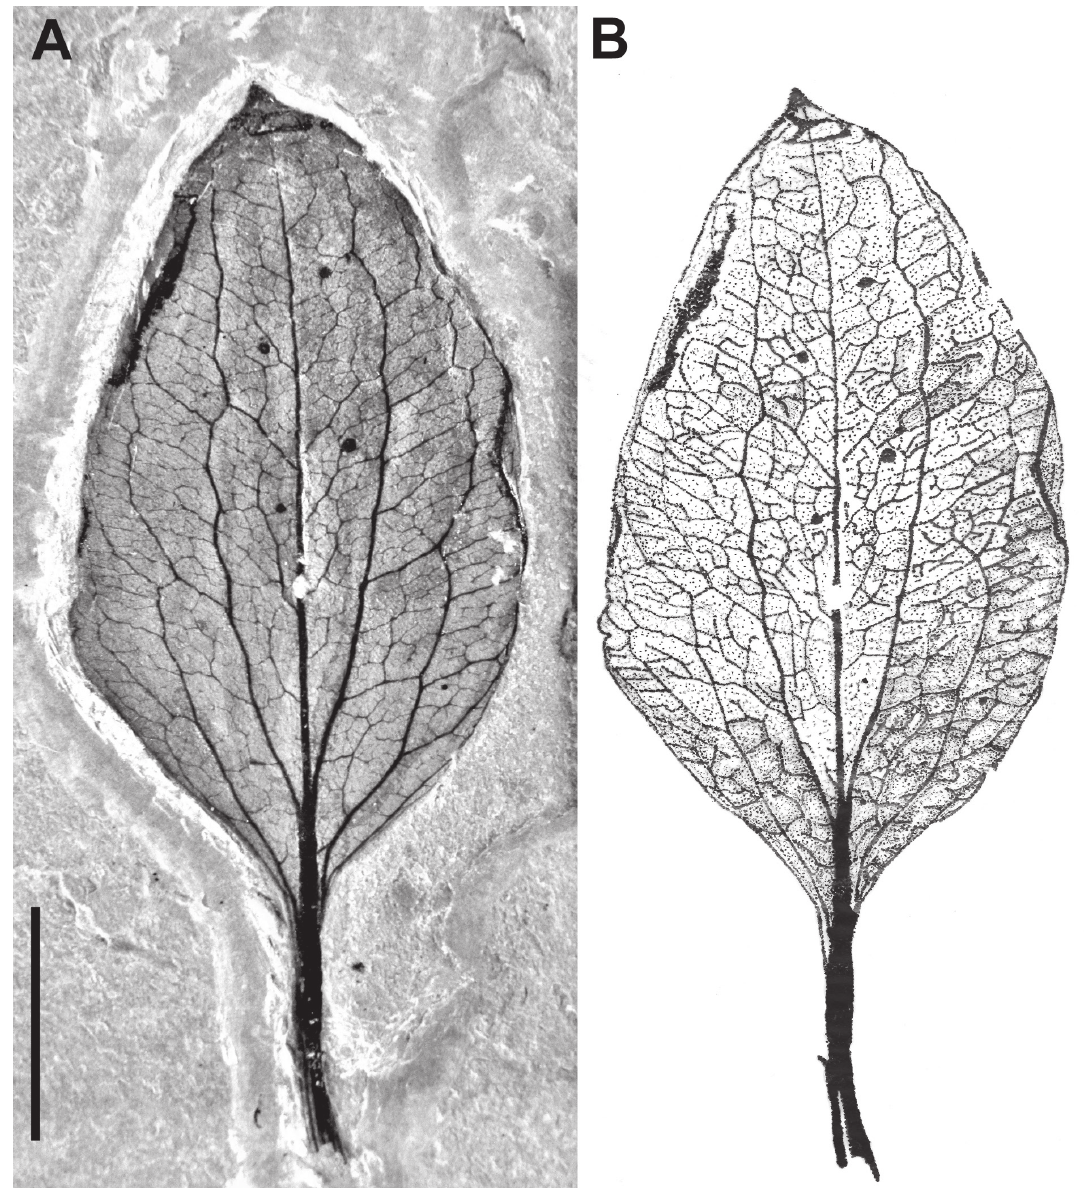
Figure 2 - Cratosmilax jacksoni gen. et sp. nov. A. Holotype, specimen MPSC PL 2400. B. Drawing of the Holopyte emphasizing the venation pattern. Scale bar = 150